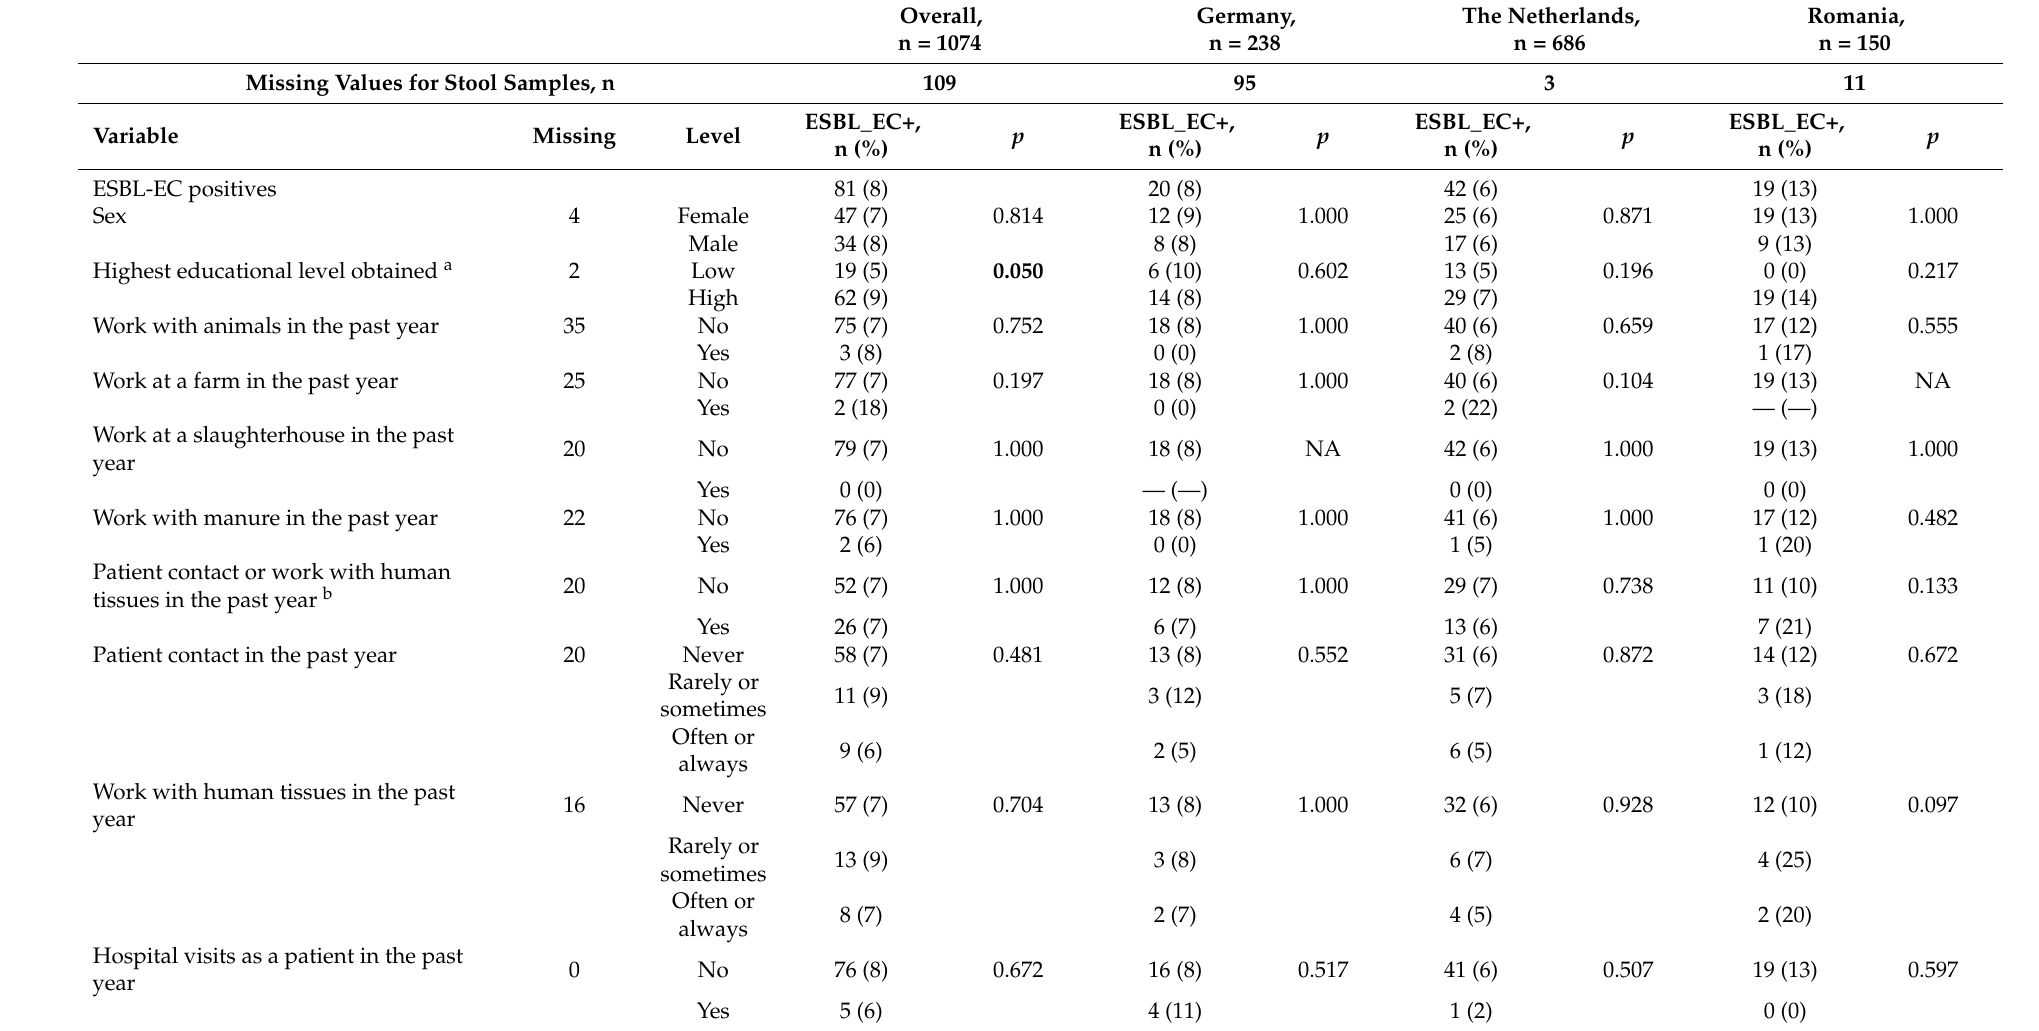
Table 1. Categorical descriptive characteristics of ESBL-producing E. coli carriers by country, n =